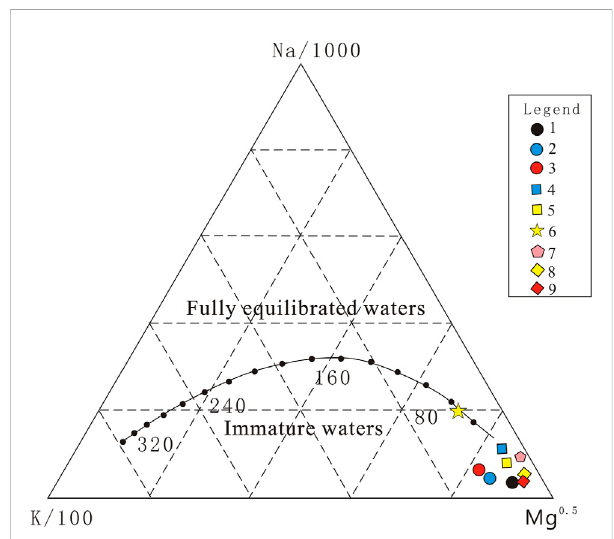
FIGURE 4 Na – K – MgdiagramoftheNo.Lu32well(thenumberinthe fi gure corresponds to that in Table 1).